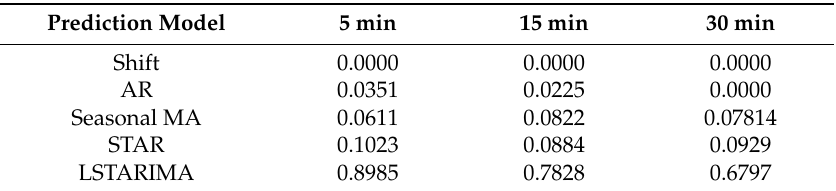
Table 3. Diebold-Mariano (DM) test results; AR: autoregressive; Seasonal MA: seasonal moving average; STAR: Space-Time